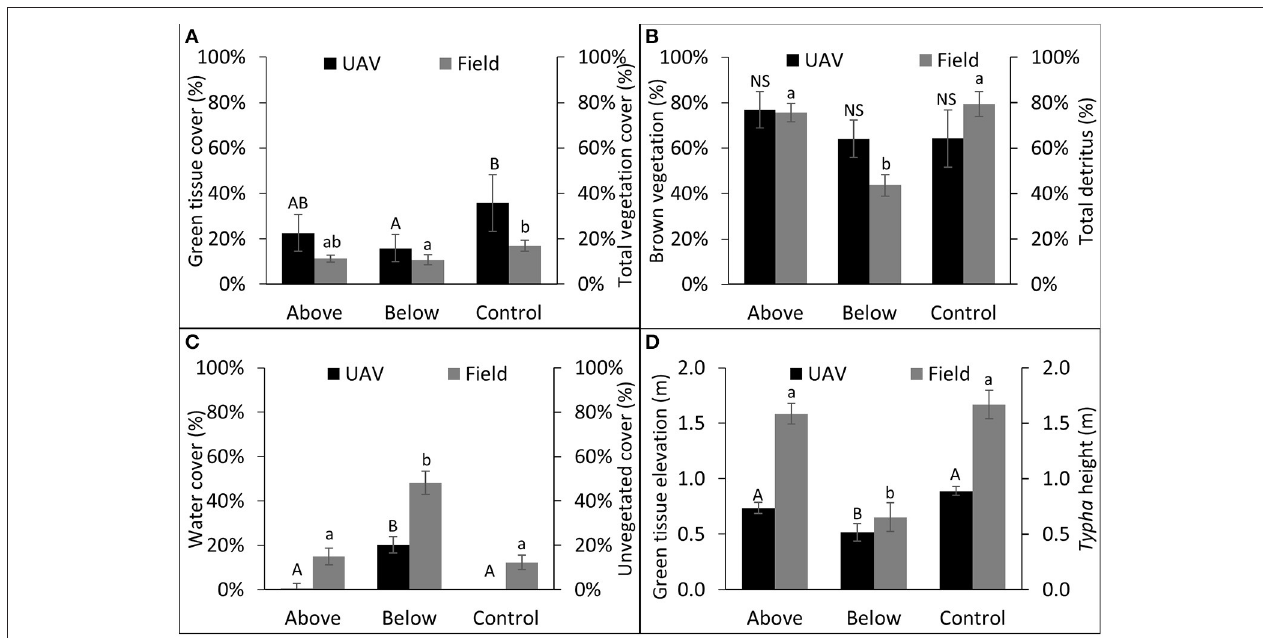
FIGURE 4 | Comparison between UAV collected data and field collected data; UAV variable on left axes and comparable field collected data on right axes. Letter differences denote significant treatment contrasts, UAV data represented by capital letters, field data represented by lowercase letters. NS denotes no significant differences between treatments ( P > 0.05). (A) UAV green tissue cover (%) (area with NDVI value > 0.28/total area); (B) UAV brown tissue cover (%) (area with NDVI values between 0.0 and 0.28/total area); (C) UAV water cover (%) (area with NDVI value > 0.0/total area); (D) green tissue height (corrected using water average water elevation).